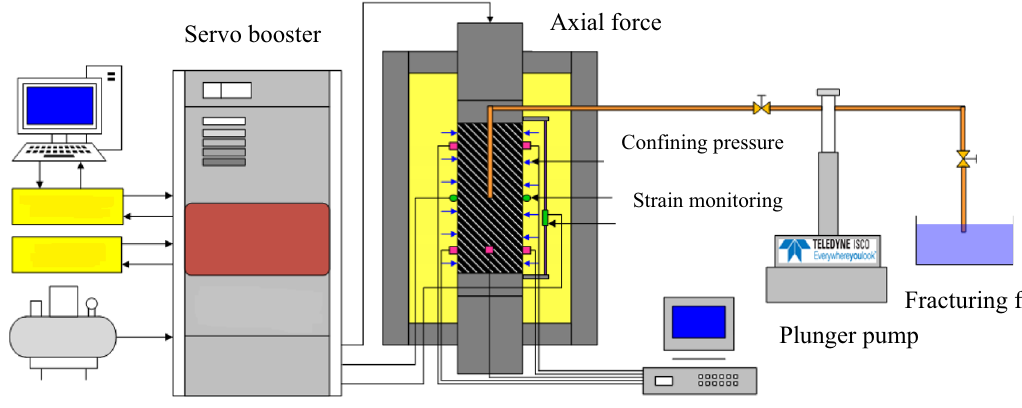
Fig. 11 Physical simulation test system for fracturing of cylinder